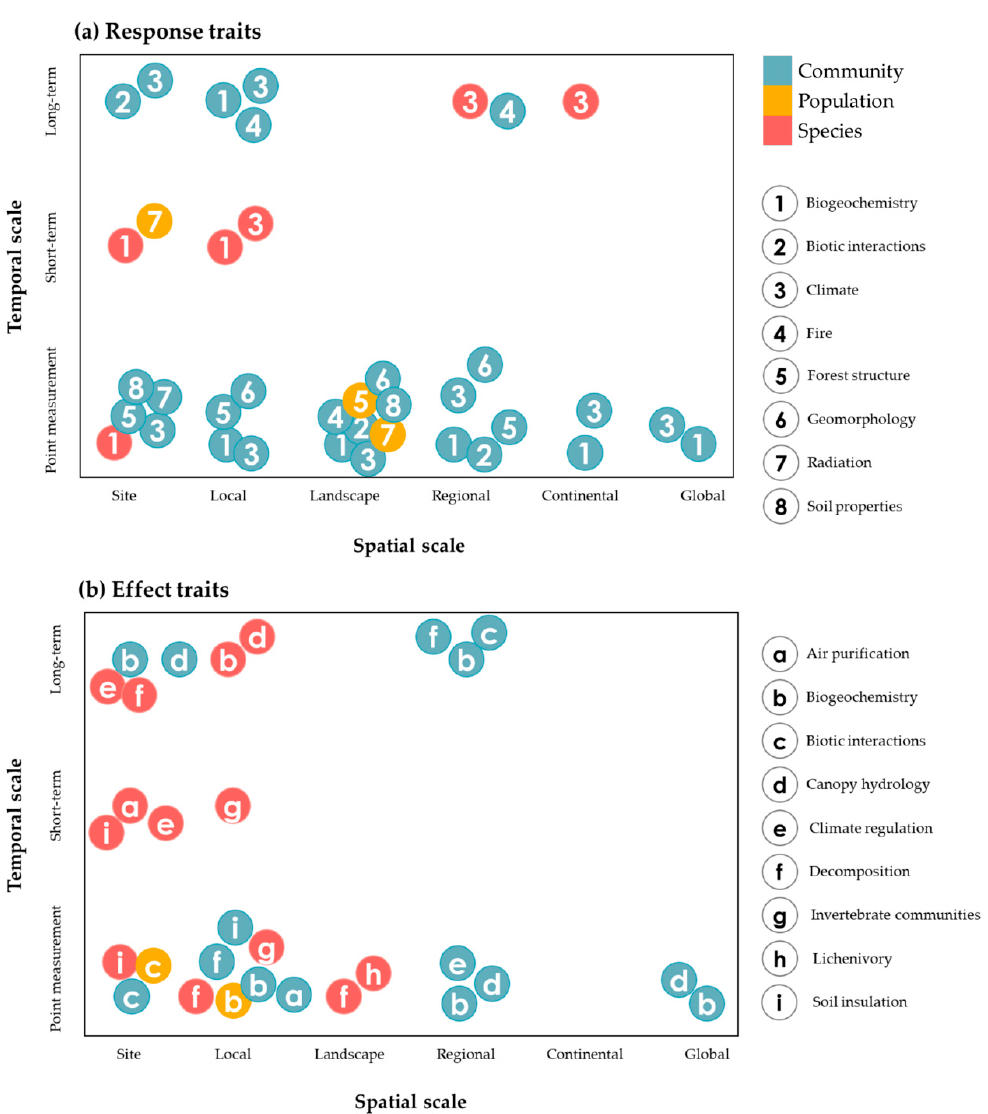
Figure 3. A sample of trait-based lichen studies, comparing the use of temporal and spatial scale (vertical and horizontal axes), when considering the scale of biological organisation (colour) and the environmental factor(s) of interest (numbered) for ( a ) response traits and ( b ) effect traits. The plot is supported by the review of studies presented in Supplementary Tables S1 and